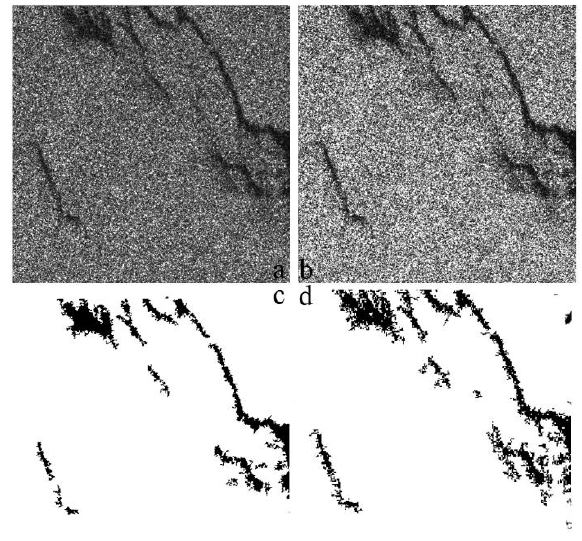
Fig.1. Results of the proposed approach on a not well-defined massive dark spot located in a very heterogeneous background (the boundary between the dark feature and the surrounding water is not well defined). (a) Original SAR images after pre- processing. (b) WMM Filtering with P=0.7, window 3x3. (c) PCNN result. (d) MLP